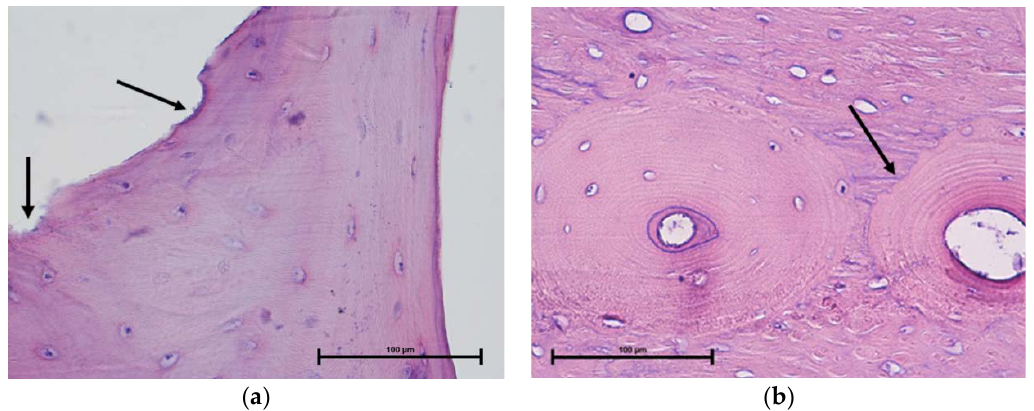
Figure 10. Erosion bays in tibia shown by arrows ( a ) and large osteon from shaft of femur, arrow indicates arrested osteogenesis ( b ). Magnification 400 ×